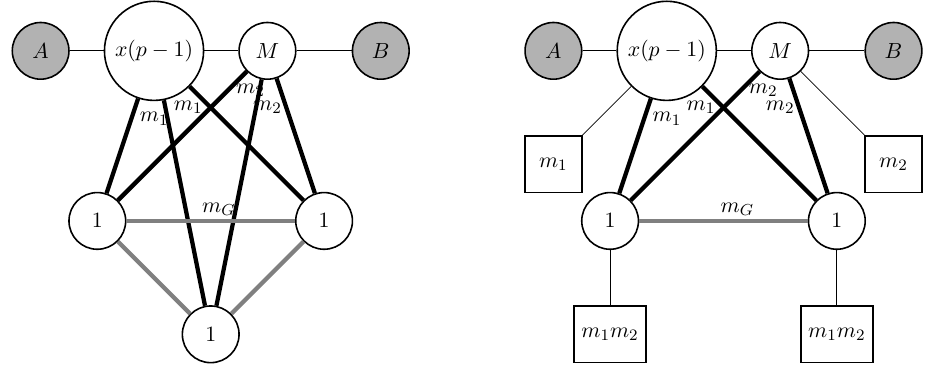
Figure 9 . The 3d mirror for the D p (SU( N )) ( p < N ) AD theory reduced on a circle, for the case m = GCD ( p, N ) = 3 . The quiver on the right is obtained by decoupling a U(1) vector multiplet associated with one of the vertices of the complete graph from the quiver on the left. The multiplicity of the edges connecting U( x ( p − 1)) with the U(1) nodes is m , and that of the edges 1 connecting U( M ) with the U(1) nodes is m . The multiplicity of edges connecting two U(1) nodes 2 is m = m G 1 m 2